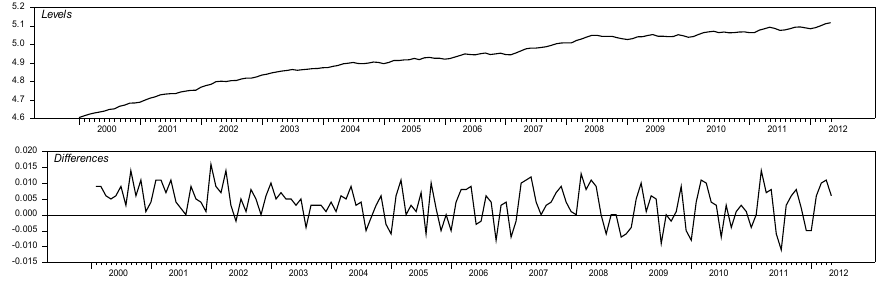
Figure 8. Logarithmic Slovenian consumer price index. Data vector January 2000 to May 2012 (Great Depression). Table 1. Descriptive statistics of nominal price indices (base period January 2000), data vector for 2000-2012.